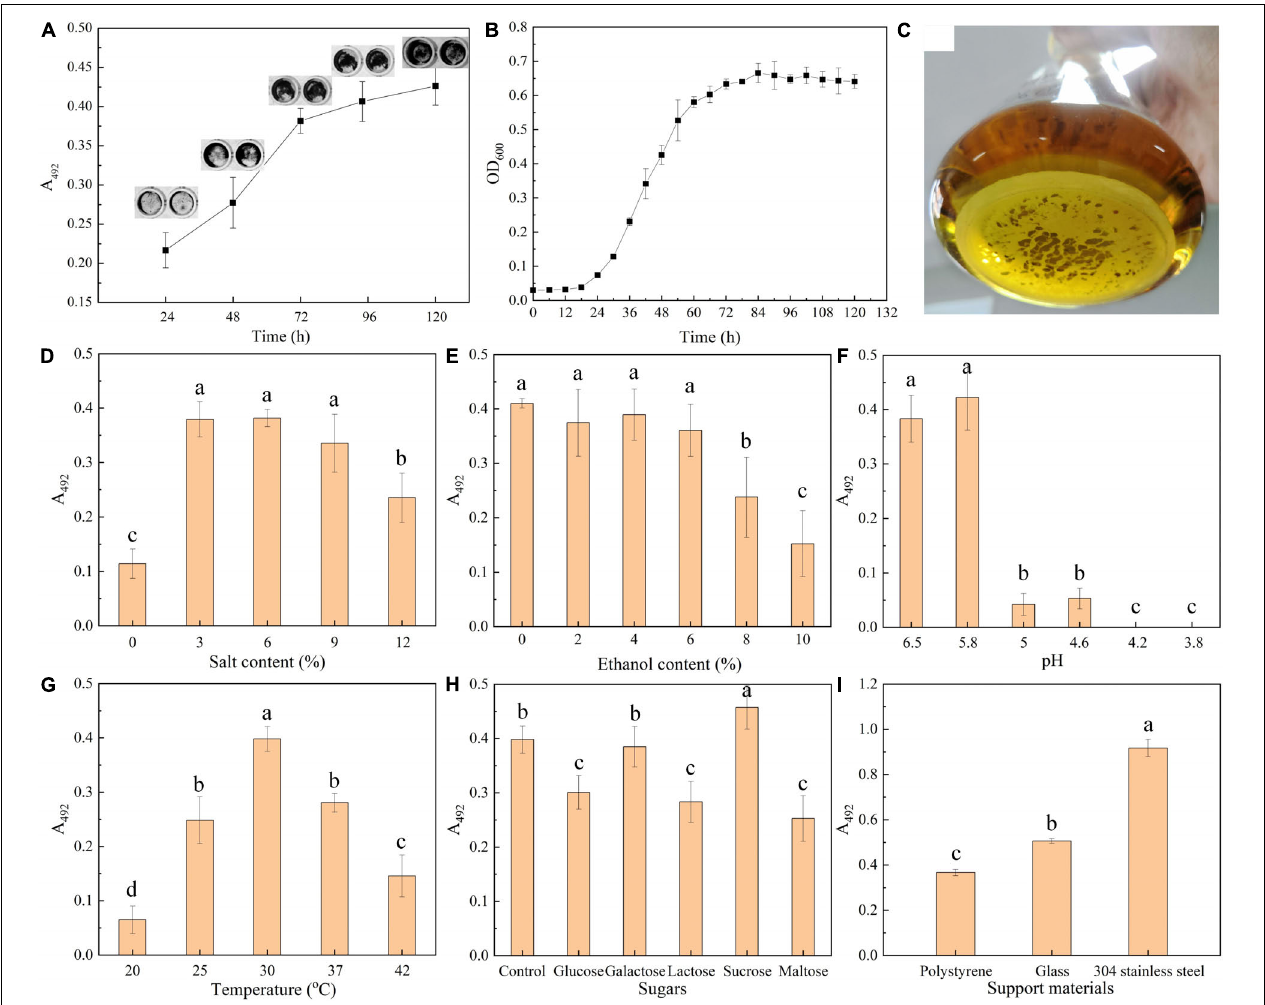
FIGURE 1 | Biofilm formation by T. halophilus . (A) Time course of biofilm formation quantified by crystal violet assay. Insets show images of stained biofilm in gray. (B) Growth curves of T. halophilus under stationary culture conditions. (C) Picture of T. halophilus biofilm taken after 120 h of incubation. (D–G) Biofilm incubated for 72 h in MRS with different salt contents (D) , ethanol contents (E) , pHs (F) , and temperatures (G) . The pH value of the MRS medium was 5.8 after autoclaving without any adjustment. (H) Biofilm incubated for 72 h in MRS added with extra 5 g/l glucose, galactose, lactose, sucrose, or maltose. (I) Biofilm incubated for 72